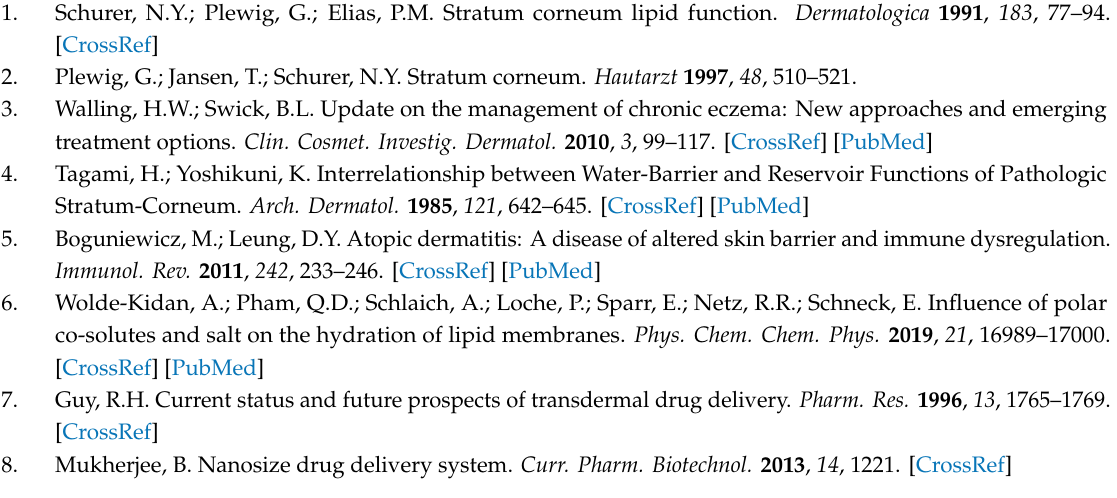
Figure S1. Structural formula of DxPCA. The spin label PCA is marked with a dotted circle. Figure S2. Numerical analysis of DxPCA penetration into barrier disrupted skin. Increased permeation compared to the healthy skin samples is observed and rationalized by an increased preference of DxPCA for the SC. The obtained partition coe ffi cients K(SC / sub) = 7.2 for the base cream formulation and K(SC / sub) = 86.9 for the nanocrystals, display this increased a ffi nity to the SC compared to the healthy skin samples. Additionally, the previously mentioned e ff ect of the nanocrystals, leading to a stronger reservoir function of the SC is even more apparent for the disrupted skin samples. Shaded areas indicated the estimated error for the di ff usion constant and free